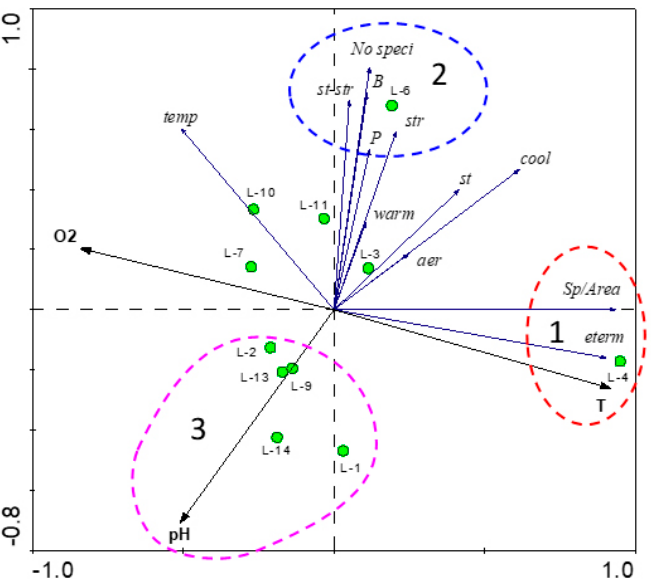
Figure 5. RDA triplot for species indicators and environmental variables in the 11 studied lakes based on the data from Table 1 and Appendix Tables A1 and A4.